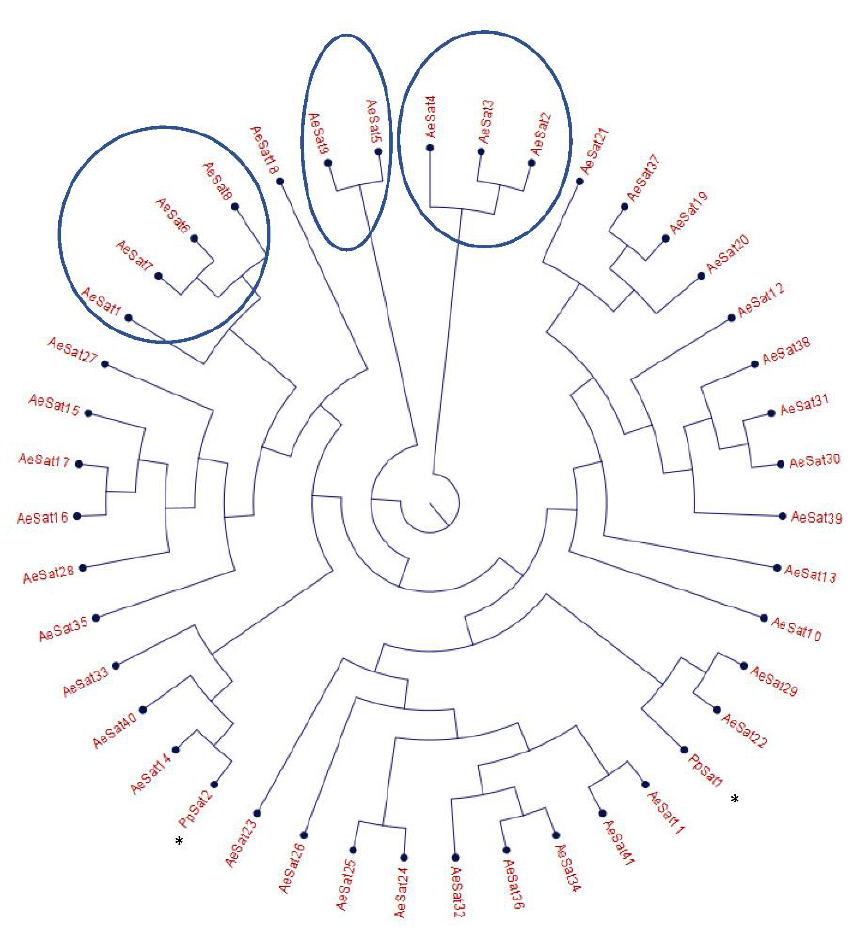
Figure 3. Phylogenetic tree of satellite DNA families from A. euteiches . Phylogenetic tree of the 41 satellite DNA families from A. euteiches , including the DNA satellite from P. parasitica * (PpSat1 and PpSat 2 [37]). HC = high number of copies of DNA satellite families (>1000 copies in the genome).